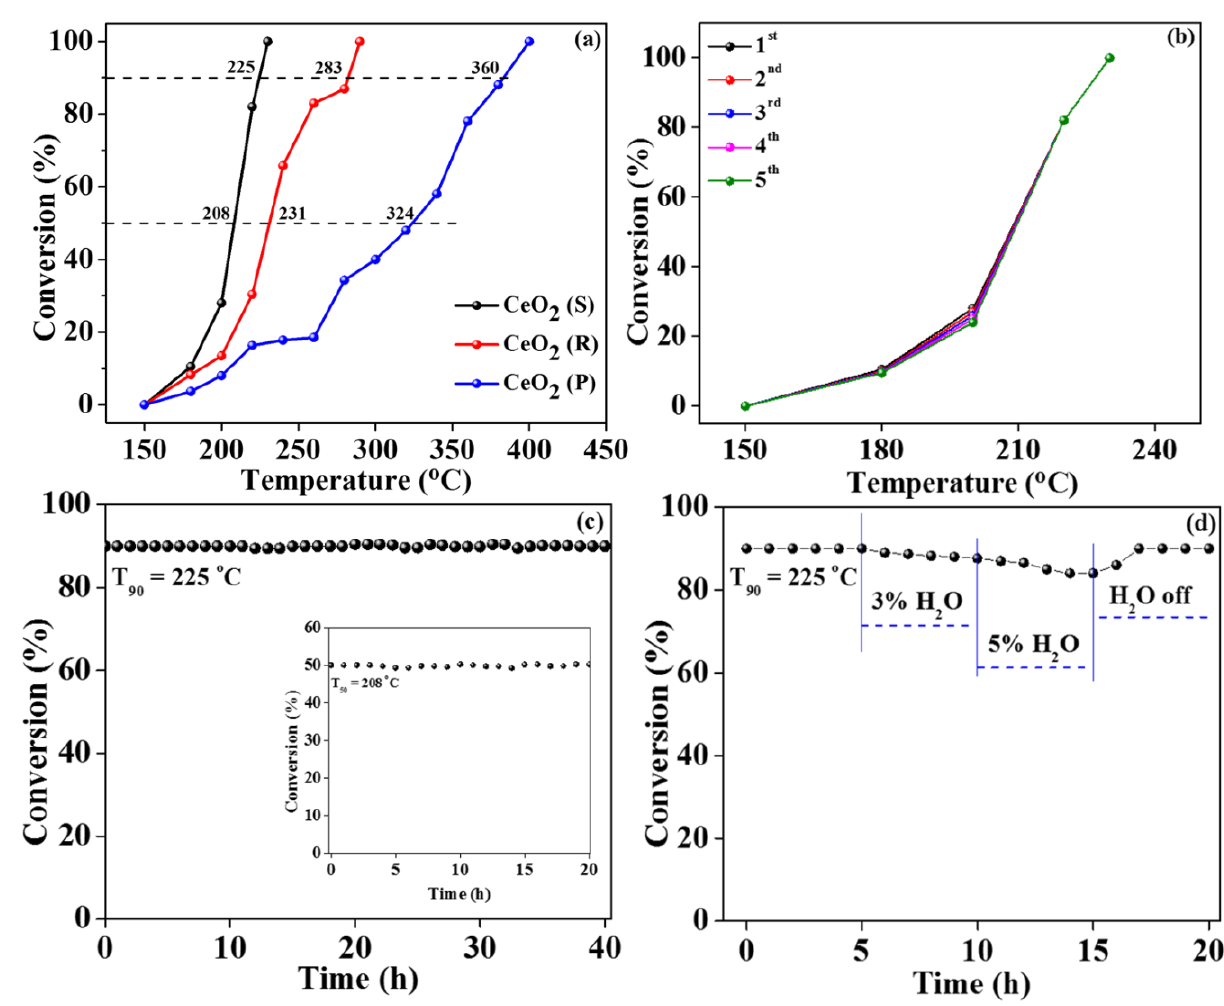
Figure 6. Catalytic oxidation activity of toluene ( a ) over CeO 2 (S), CeO 2 (R), and CeO 2 (P); catalytic activity for five consecutive cycles ( b ); catalytic activity stability as a function of time ( c ) and resistance to water ( d ) over CeO 2 (S). Table 2. The catalytic activity, reaction rate, TOF ov at 190 ◦ C and Ea of the CeO 2 (S), CeO 2 (R), and CeO 2 (P).